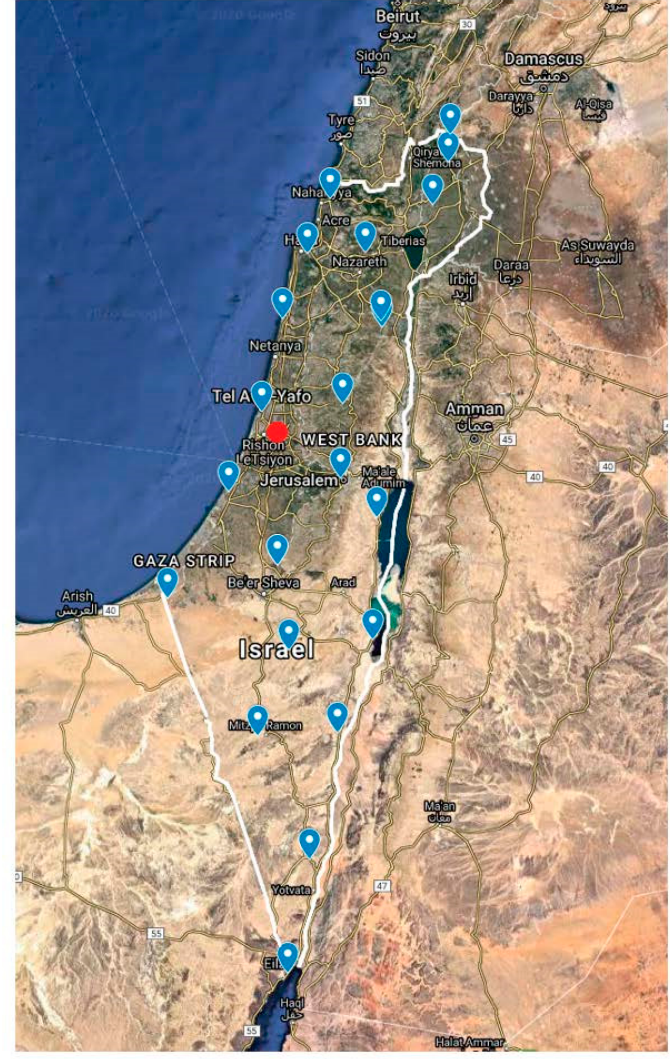
Figure 1. Israel’s survey of Israel–active permanent network (SOI-APN) global positioning sys- tems (GPS) network. The Survey of Israel (MAPI) is maintaining the network, which consists of 24 permanent geodetic GPS receivers. The Bed Dagan radiosonde location is marked by the red cir- cle.